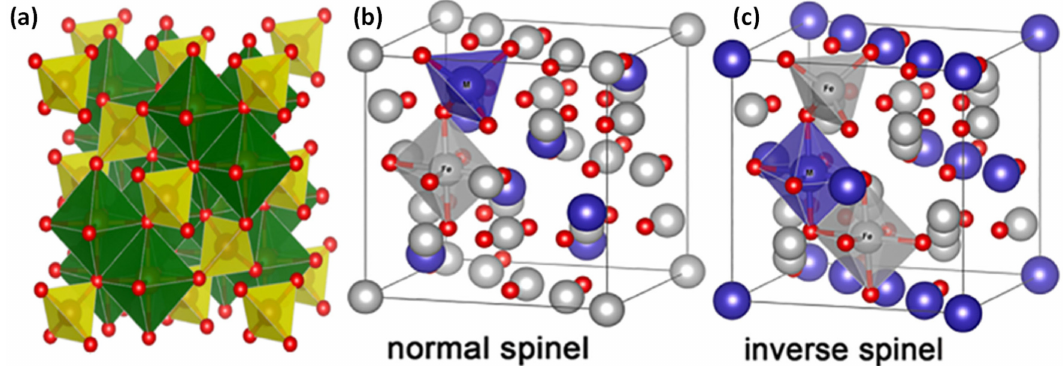
Figure 1. Structure of magnetic spinel ferrite showing tetrahedral sites (yellow), octahedral sites (green), and oxygen atoms (red) units ( a ) [12]. Unit cell structure of ( b ) normal spinel ferrite, and ( c ) inverse spinel ferrite [25]. Republished with permission from